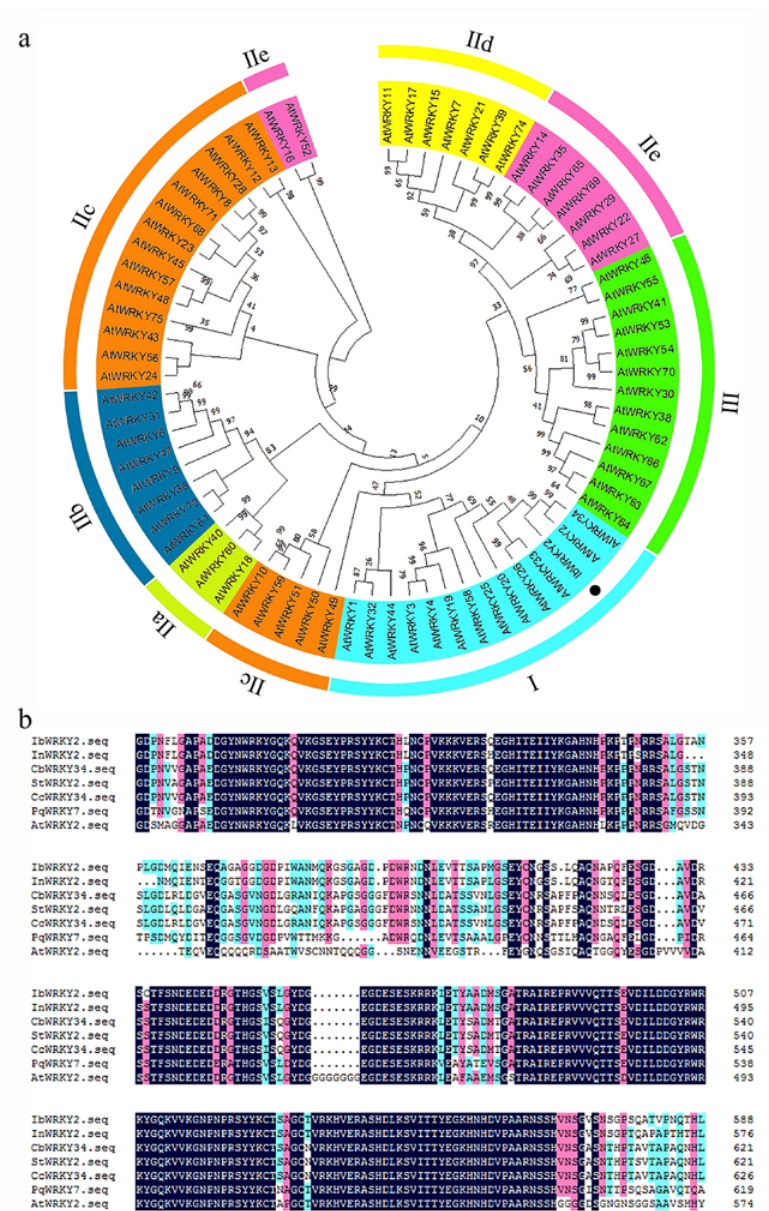
Figure 1. Phylogenetic relationship and conserved domain analysis of IbWRKY2. ( a ) Phylogenetic analysis of IbWRKY2 and 71 WRKY transcription factors from Arabidopsis . Roman numerals indicate di ff erent subfamilies of WRKY proteins and the black dot in the phylogenetic tree indicates IbWRKY2. ( b ) Amino acid sequence alignment of IbWRKY2 with homologs from NCBI. The conserved WRKY domains are marked by black lines.